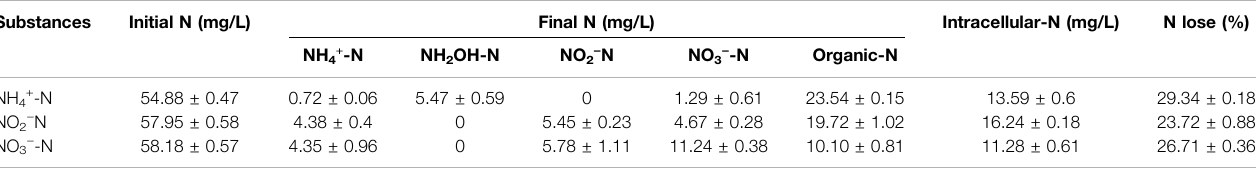
TABLE 1 | Nitrogen balances of ammonium, nitrite and nitrate removal by strain EM-A1. Substances Initial N (mg/L) Final N (mg/L) Intracellular-N